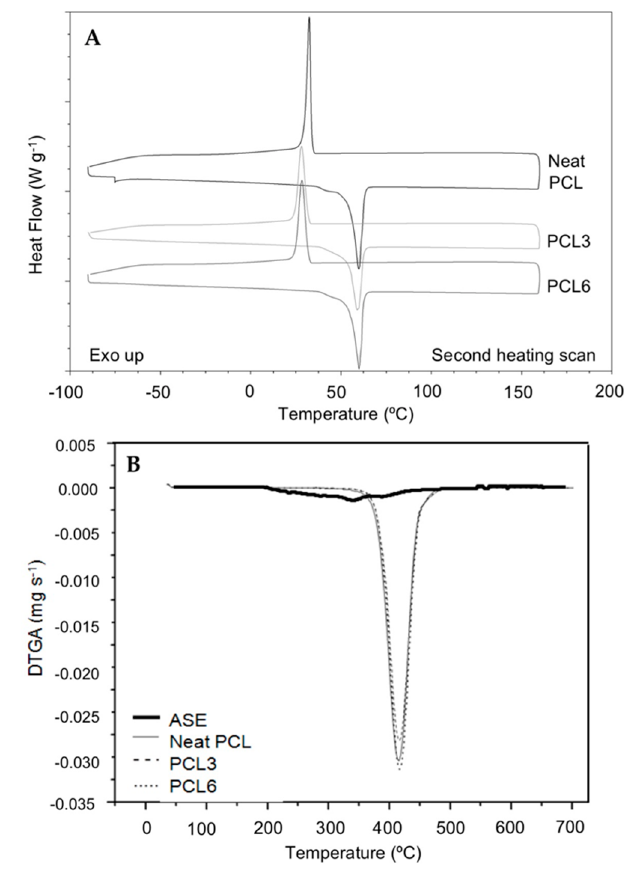
Figure 3. ( A ) DSC curves obtained for neat PCL, PCL3, and PCL6 during the second heating scan in nitrogen atmosphere (10 ◦ C min − 1 ); ( B ) DTGA curves for neat PCL, PCL3, PCL6 and ASE in inert atmosphere (10 ◦ C min − 1 ).